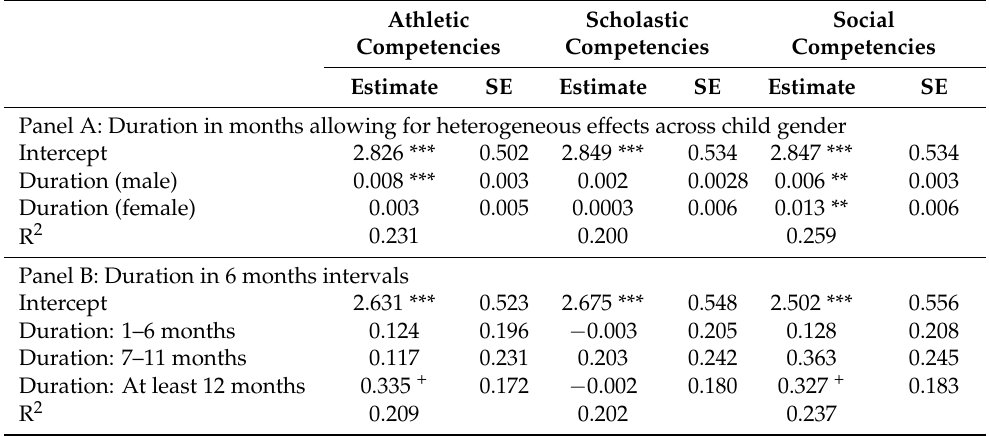
Panel B: Duration in 6 months intervals Intercept 0.548